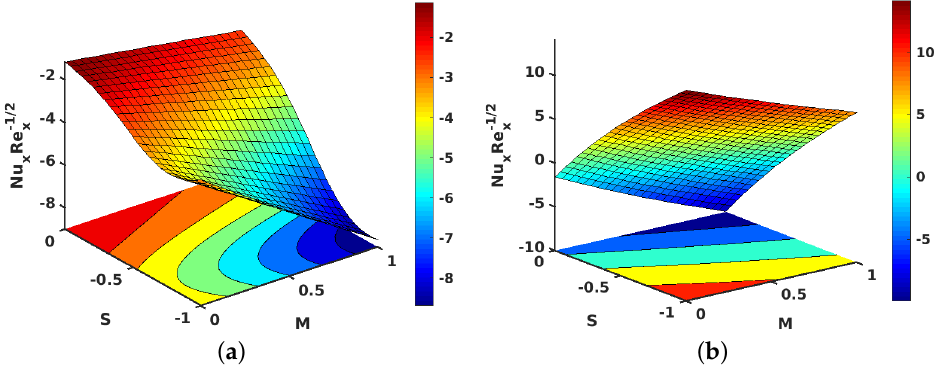
Figure 14. Effect of unsteadiness parameter ( S ) and magnetic parameter ( M ) on the local Nusselt number. ( a ) Injection; ( b ) suction.